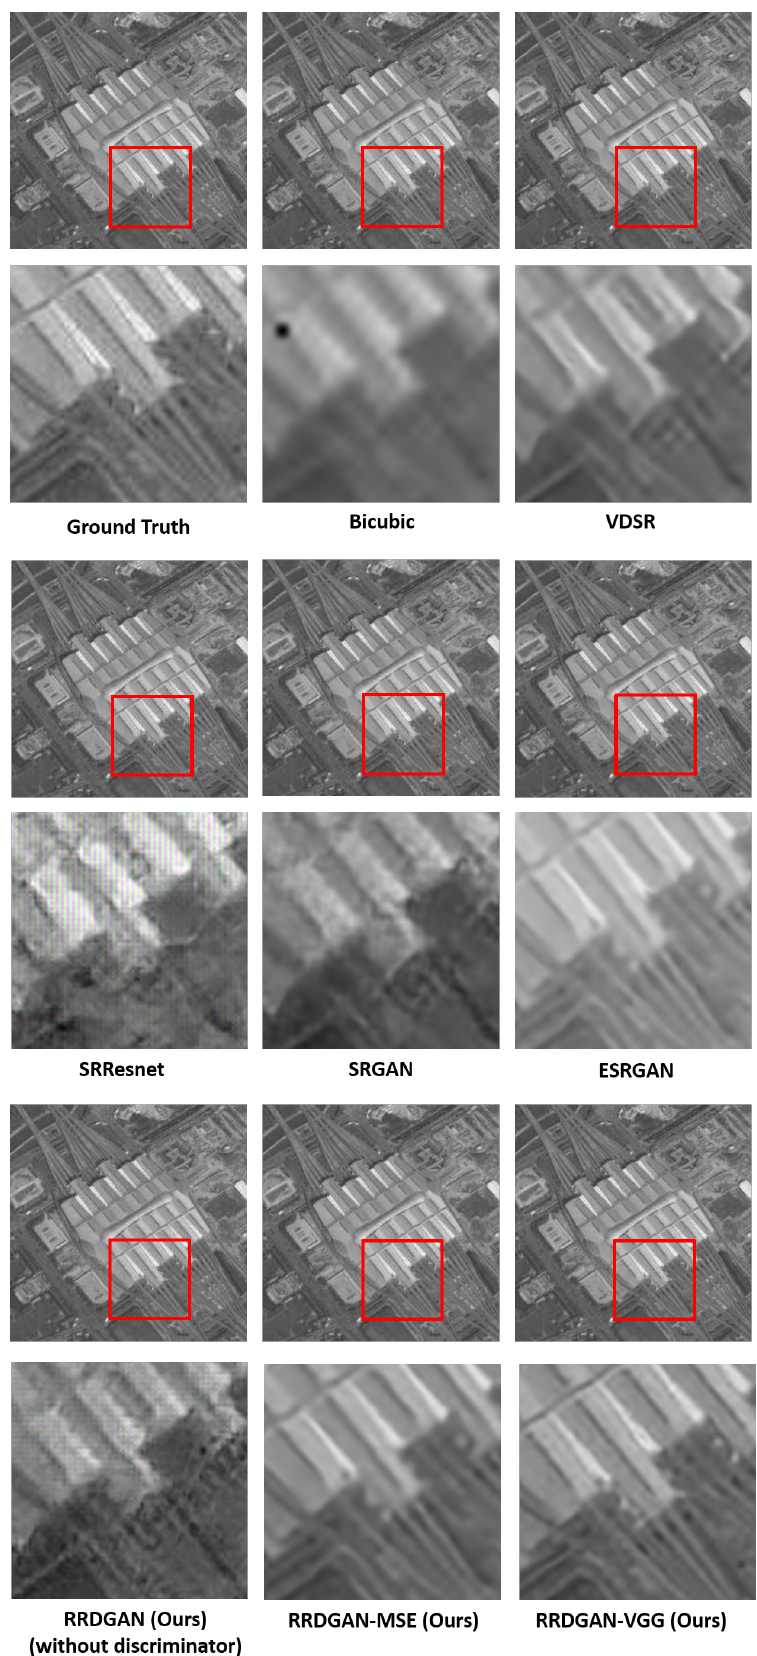
Figure 11. Comparison results among different methods of “Railway”, scale factor is